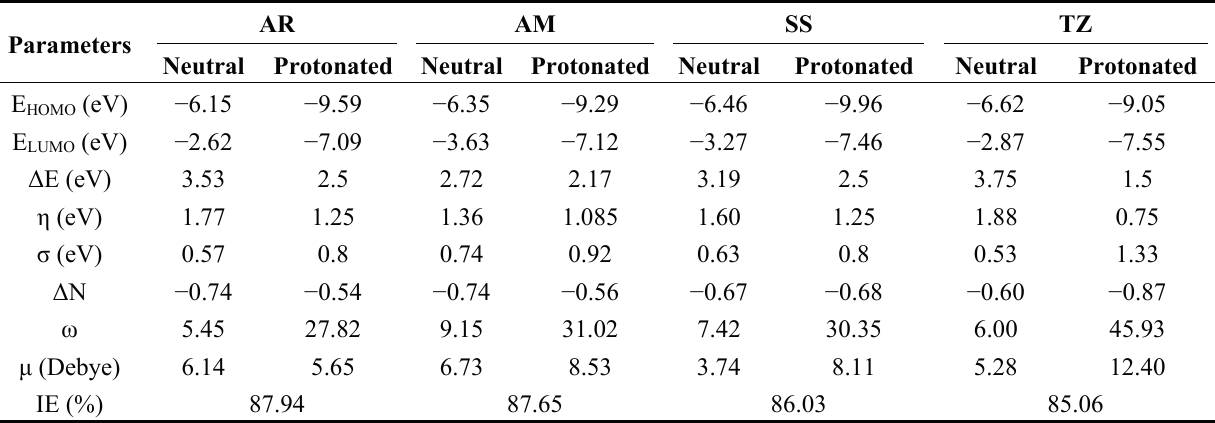
Table 5. Selected quantum chemical parameters for the studied dyes considering both the neutral and the protonated